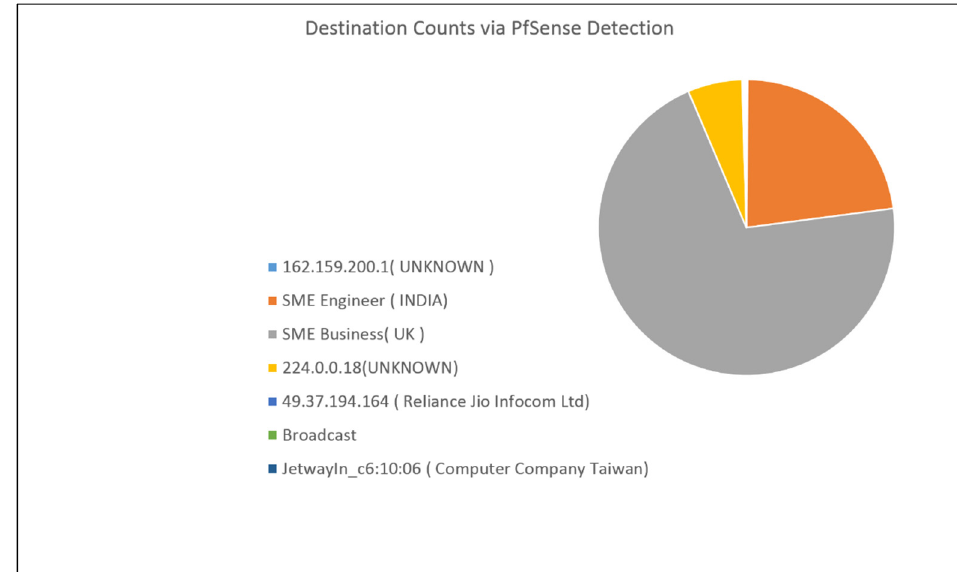
Figure 17. Destination Counts via pfSense Detection extracted from pfSense.